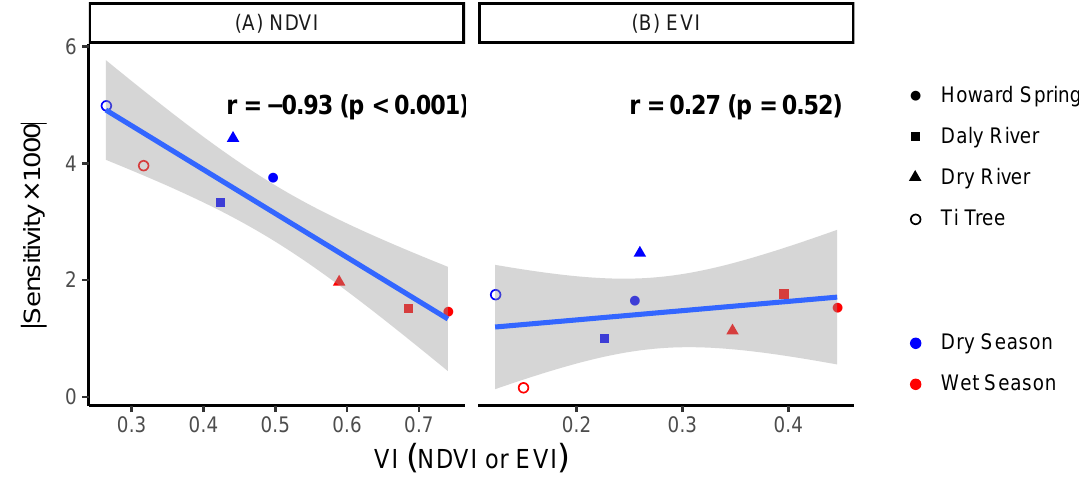
Figure 7. Sensitivity of vegetation indices to sun-angle variations, in absolute values, as a function of vegetation greenness. ( A ) Changes in NDVI sensitivity to SZA variation as a function of NDVI across four sites and across wet and dry seasons. ( B ) Changes in EVI sensitivity to SZA variation as a function of EVI across four sites and across wet and dry seasons. Sensitivity of VI to SZA is computed as the slope in the relationship between the change in rescaled VI (VI / VI SZA-0 ) to the unit change in SZA (refer to Figure 6) and hence sensitivity is comparable between NDVI and EVI (i.e., a higher sensitivity means a higher percentage of change in VI, relative to VI SZA-0